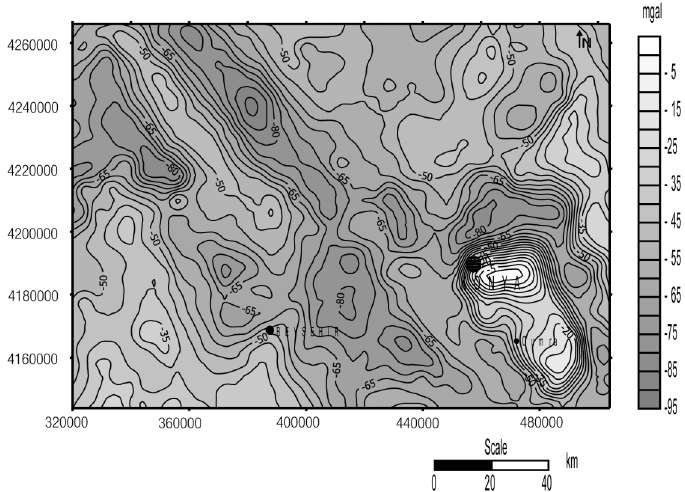
Fig. 6. Gravity anomaly map of Konya-Beysehir Region (the original map is obtained from MTA. The contour interval is 5 mgal).